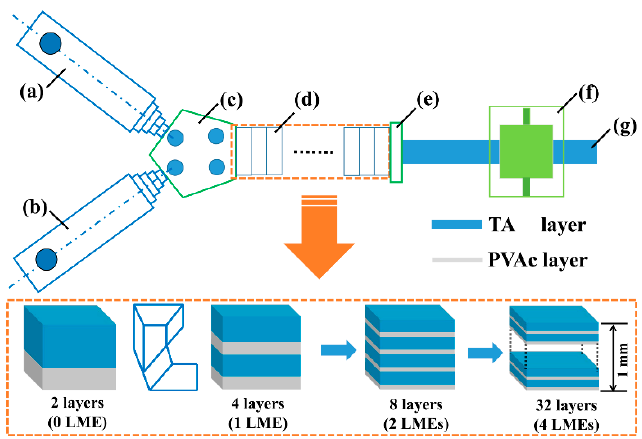
Figure 1. Schematic of multilayered co-extrusion system: ( a , b ) single screw extruder; ( c ) co-extrusion block; ( d ) laminating-multiplying elements (LMEs); ( e ) exit block; ( f ) rolling and cooling block and ( g ) multilayer sheet. ( g ) multilayer